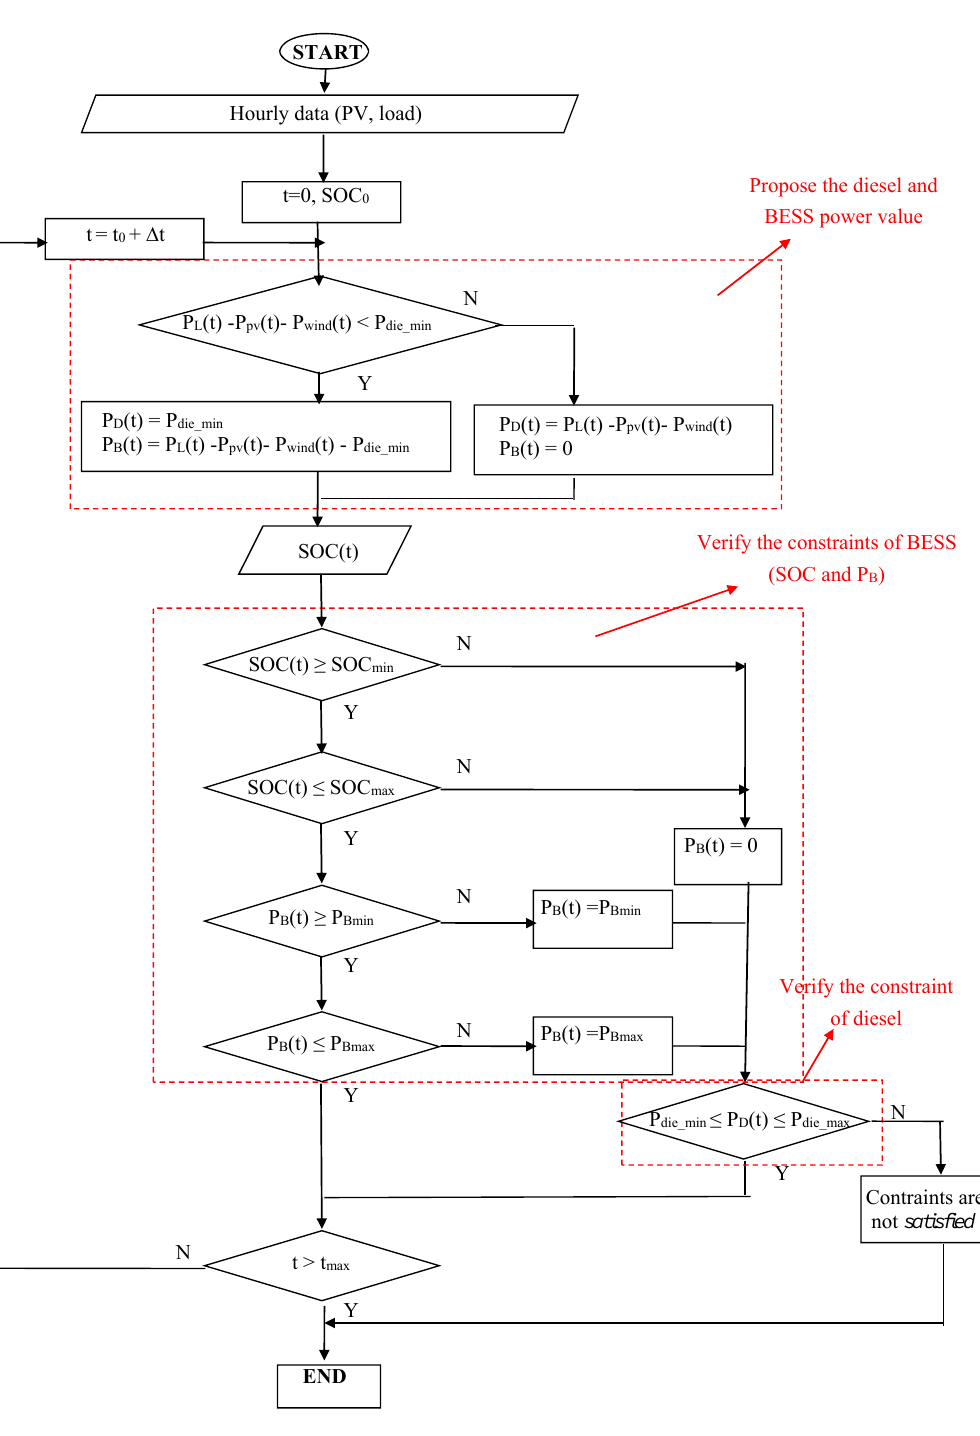
Figure 2. The flowchart of rule-based management for a hybrid